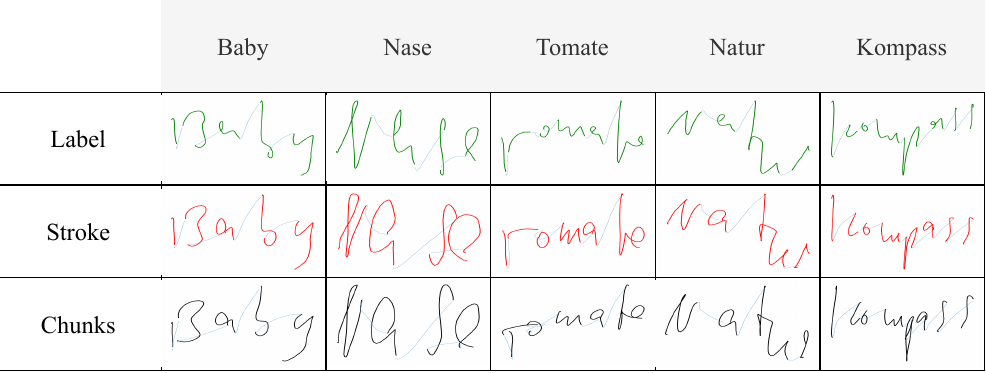
Figure 6. Trajectory recovery results when writing on tablet, including the ground truth trajectory collected by the tablet.